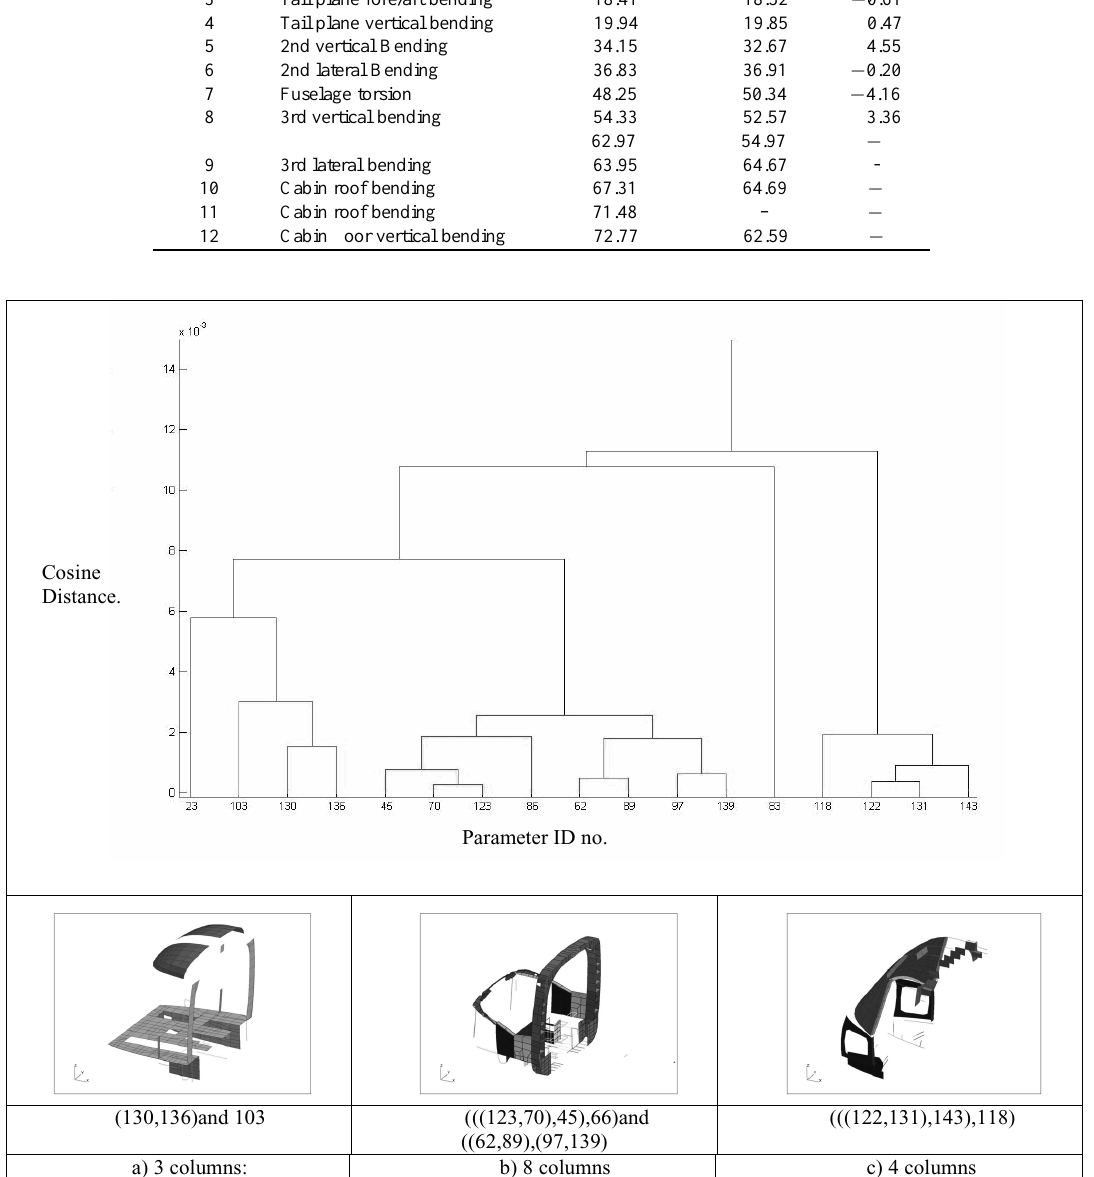
Fig. 6. Clustering of three groups in the cabin region: 5 ◦ angle